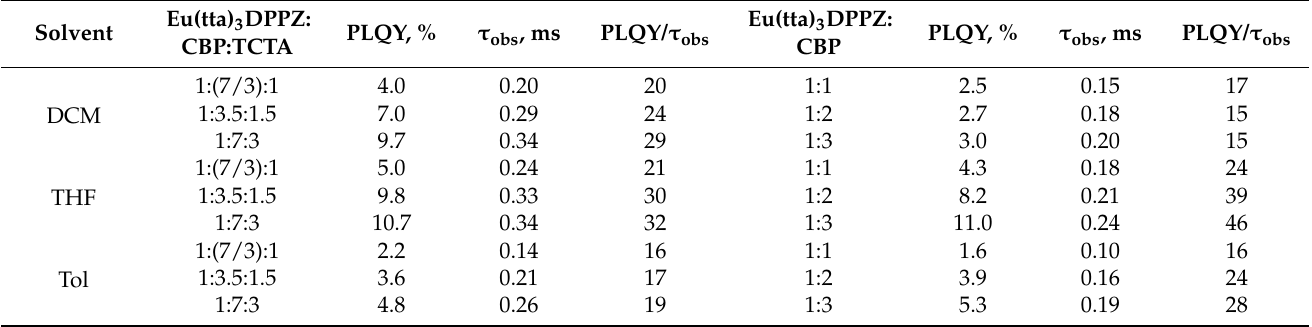
Table 2. The solvent dependence of the photophysical properties of the Eu(tta) 3 DPPZ-doped films.